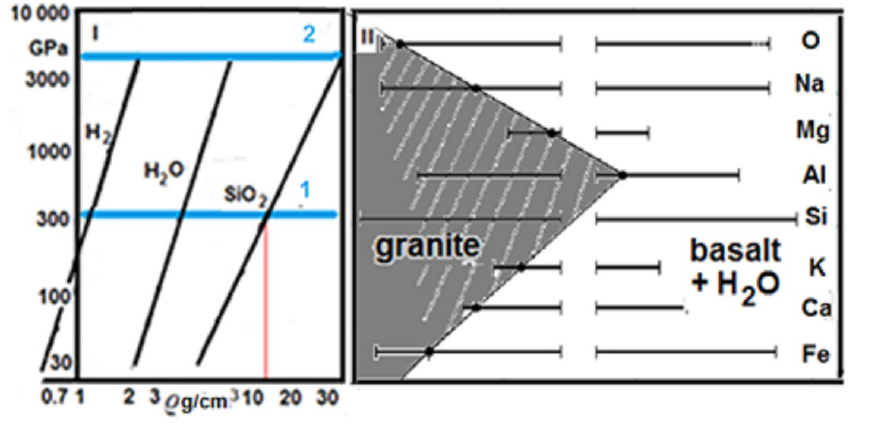
Fig. 7. I illustrates the main components of the Earth matter (pressure-depending density of H 2 , H 2 O and SiO 2 ) [1]. Blue lines (BL): 1 - pressure in the center of the modern Earth, 2 – at the time of its formation. Fig. 7-II shows how one part of granite (grey) can be obtained from two parts of basalt [1]. The chemical elements of basalt are indicated at the right. The length of the strip shows the relative concentration of basalt. Relative concentrations of Si in granite and basalt are assumed to be equal. The concentration of Al in granite is greater than in basalt. If we assume that when heated, a part of basalt will evaporate, then the darkened part which is granite will